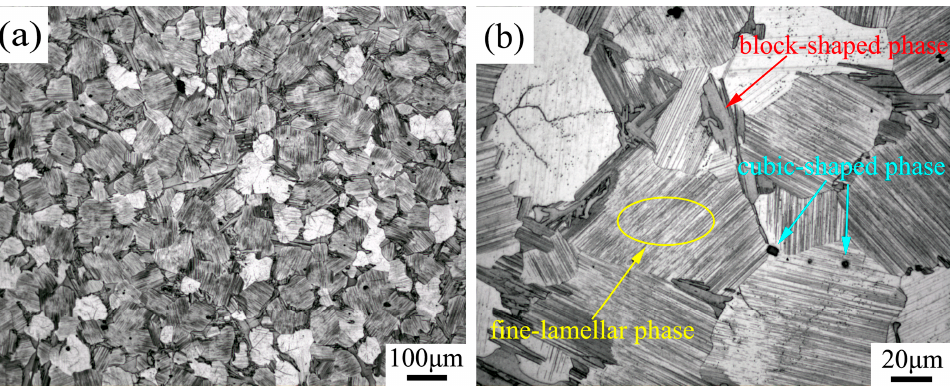
Figure 2. Optical microscopy (OM) images of: ( a ) the as-cast alloy; and ( b ) the corresponding magnified image.